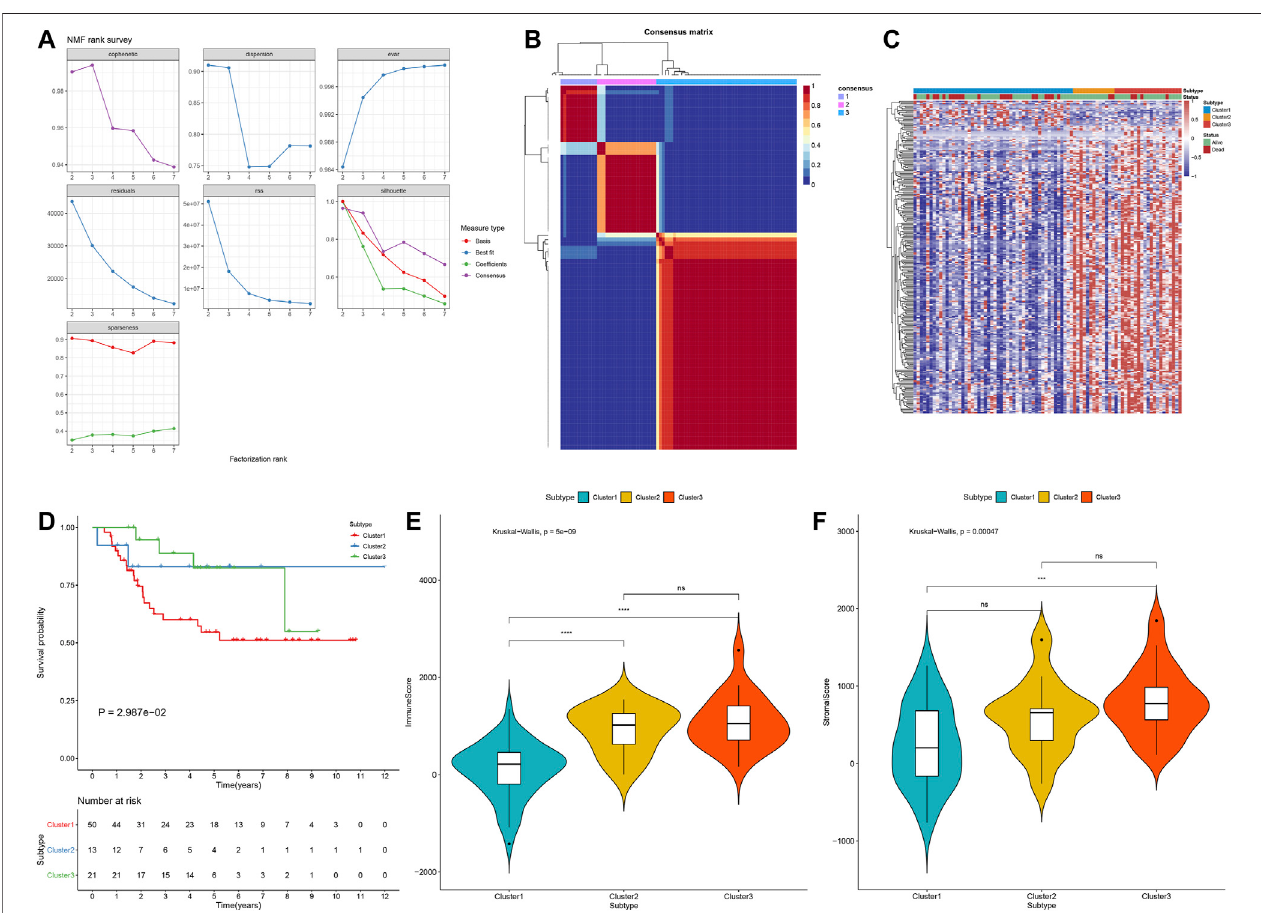
FIGURE 9 | Establishment of osteosarcomasubtypes with distinct prognostic implications in the TARGETcohort based on the 272 stromal-immune score-based DEGs with the NMF algorithm. (A) The relationships between cophenetic, dispersion, evar, residuals, rss, silhouette and sparseness coef fi cients, and the number of clustering. (B) Heat map of nonnegative matrix factorization (NMF) clustering results of stromal-immune score-based signatures with clustering number (cid:1) 3. (C) The heatmap of the differences in expression of the 272 stromal-immune score-based DEGs among three clusters. (D) Kaplan – Meier curves of OS for osteosarcoma patients in the TARGET cohort with three molecular subtypes. P for log-rank test. (E) The immune scores in three stromal – immune score-based clusters using the ESTIMATE algorithm. (F) The stromal scores of three gene clusters with the ESTIMATE algorithm. The differences between three subtypes were compared